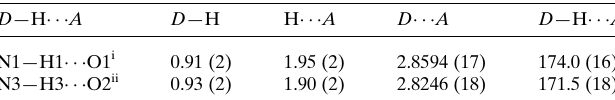
Table 1 Hydrogen-bond geometry (A˚ , (cid:5) ).